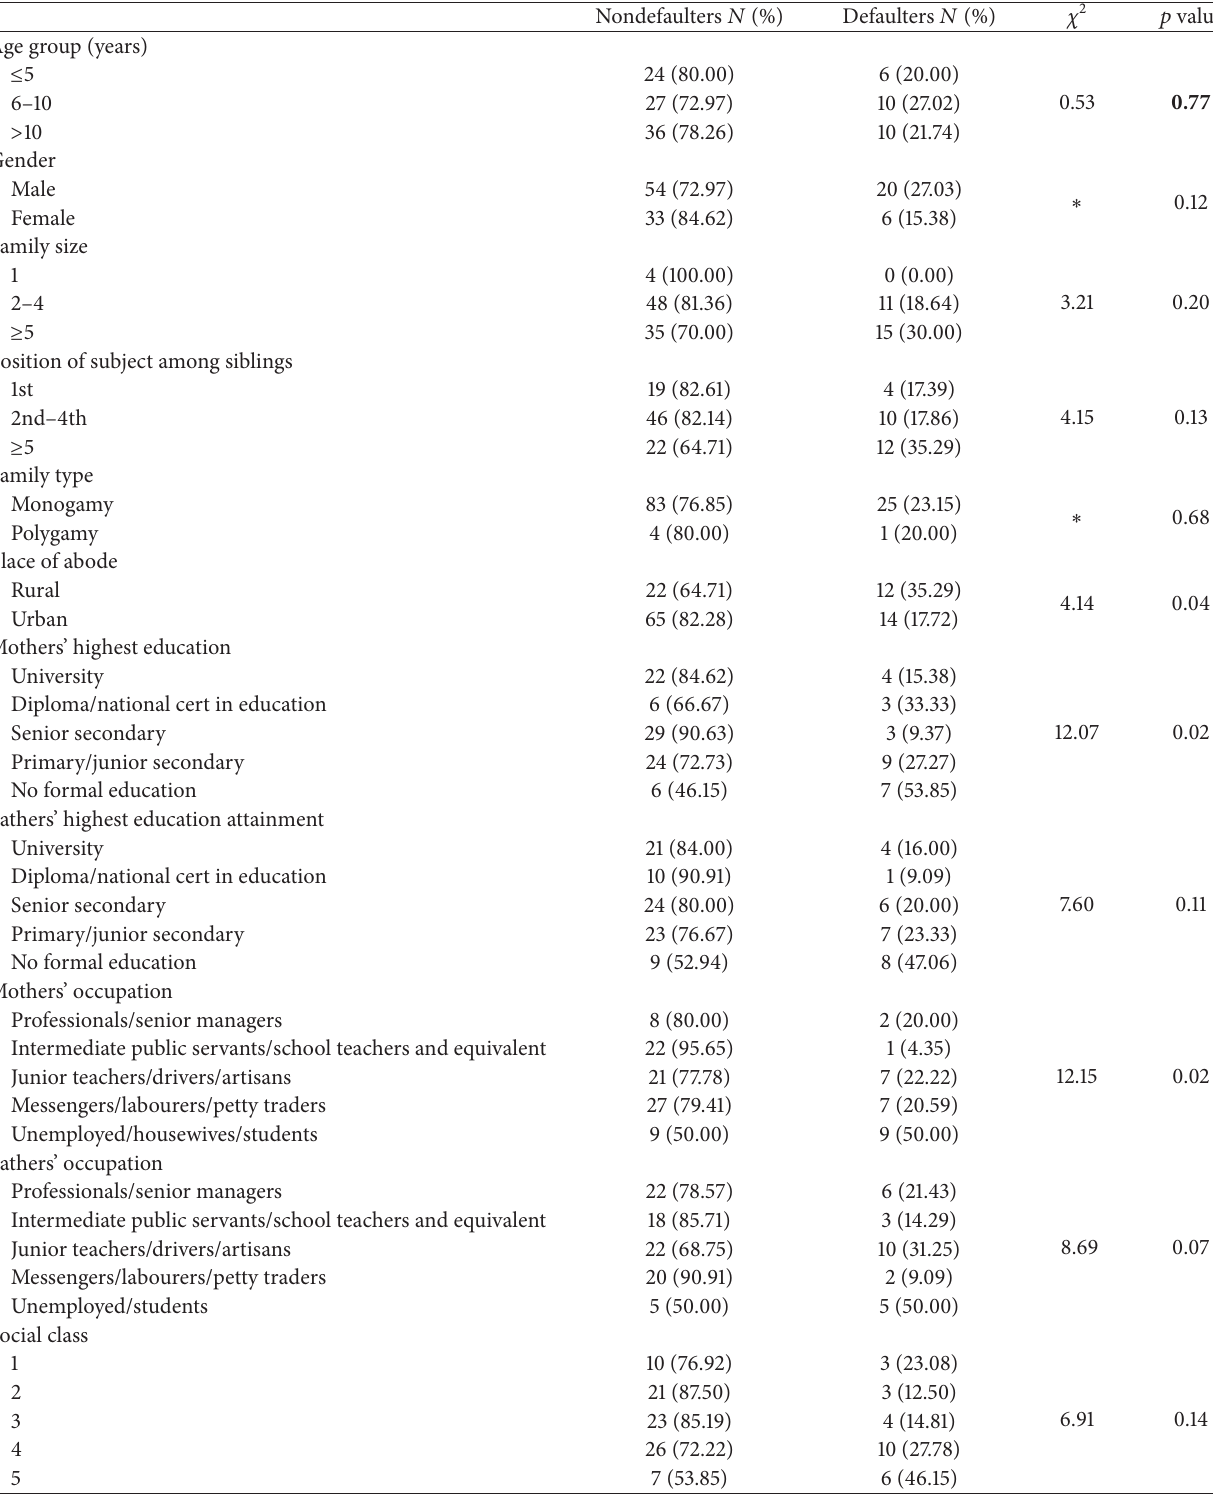
Table 1: Association of noncompliance to clinic appointments and some sociodemographic variables among children with